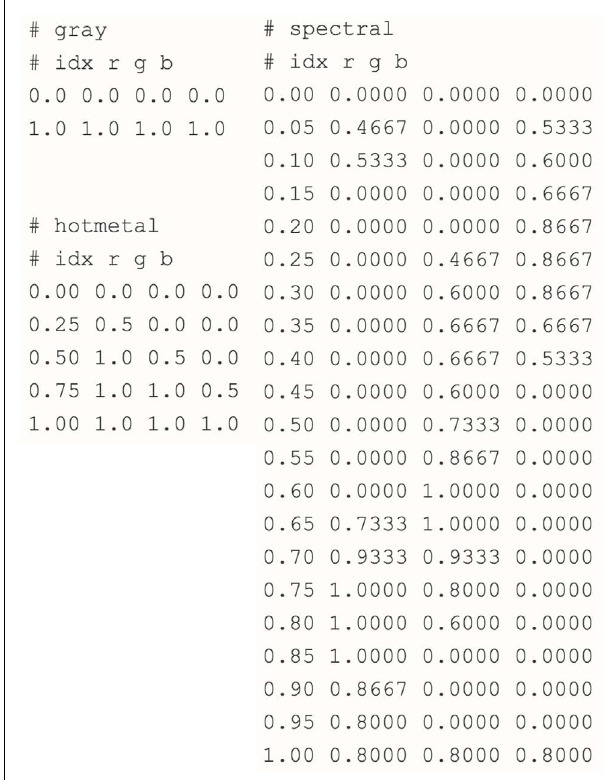
of each color map represents the gray-scale intensity. The other three represents the RGB values mapped to the first column. All the value goes from 0 to 1. The number of steps (rows) from 0 to 1 defines the complexity of the spectrum of the color